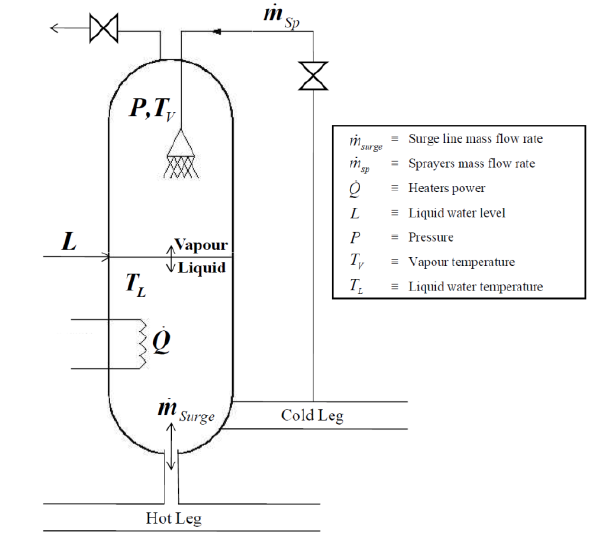
Fig. 9. Simplified model of a pressurizer. Table 1. Initial conditions of the pressurizer